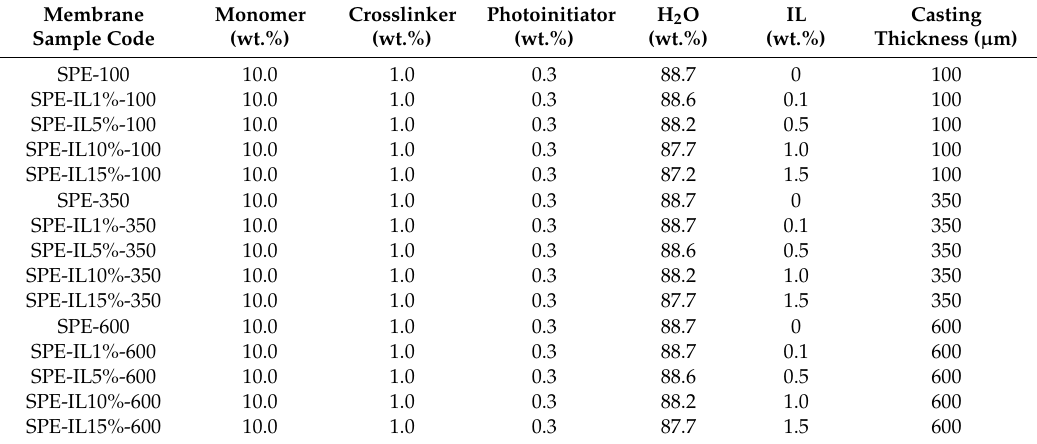
Table 1. Hydrogel composite membrane sample codes, compositions of the pre-polymerization solution and thickness of the casted film